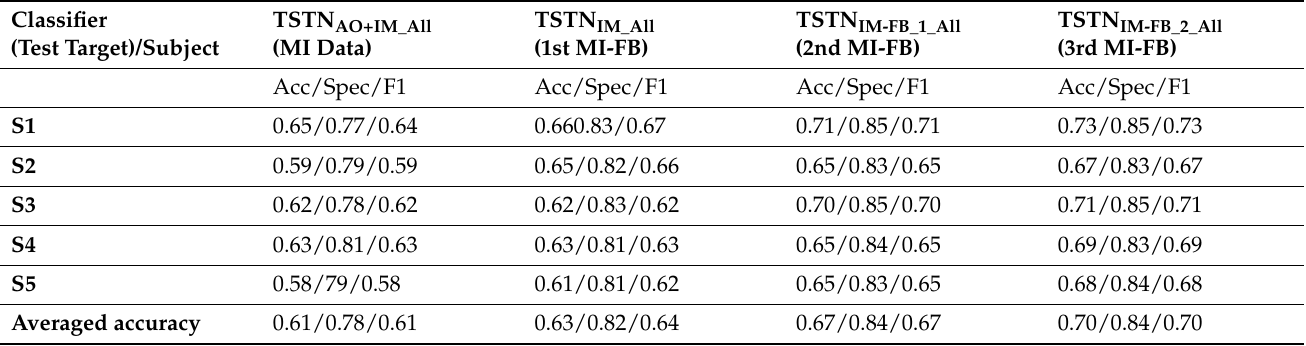
Table 2. Classification results of the TSTN network using the training data pooled for all